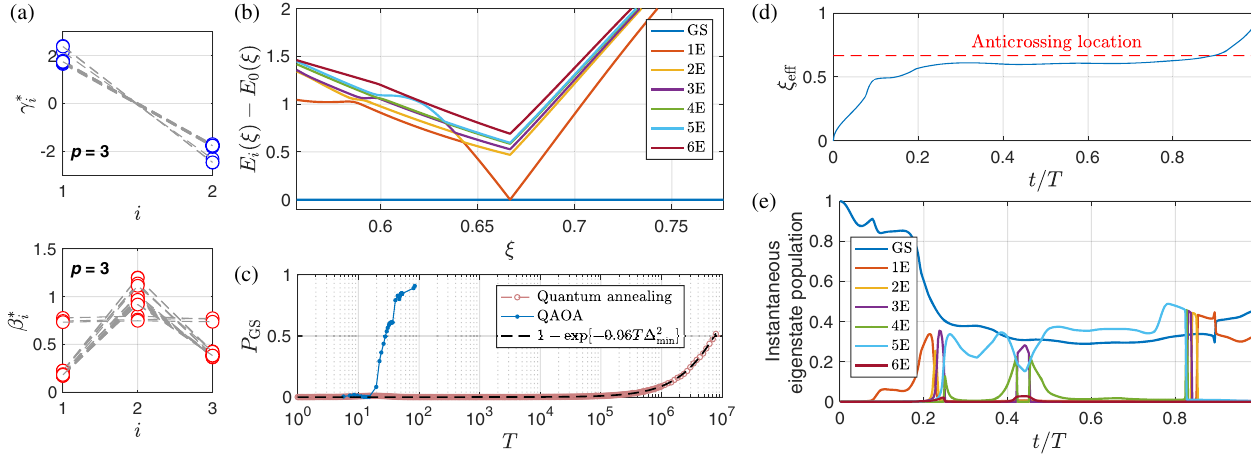
0 . 0012 at ξ ¼ 0 . 6666 . (c) Comparing min ¼ P P p − 1 p γ β i j þ i j . (d) The effective i ¼ 1 j i ¼ 1 j QAOA ¼